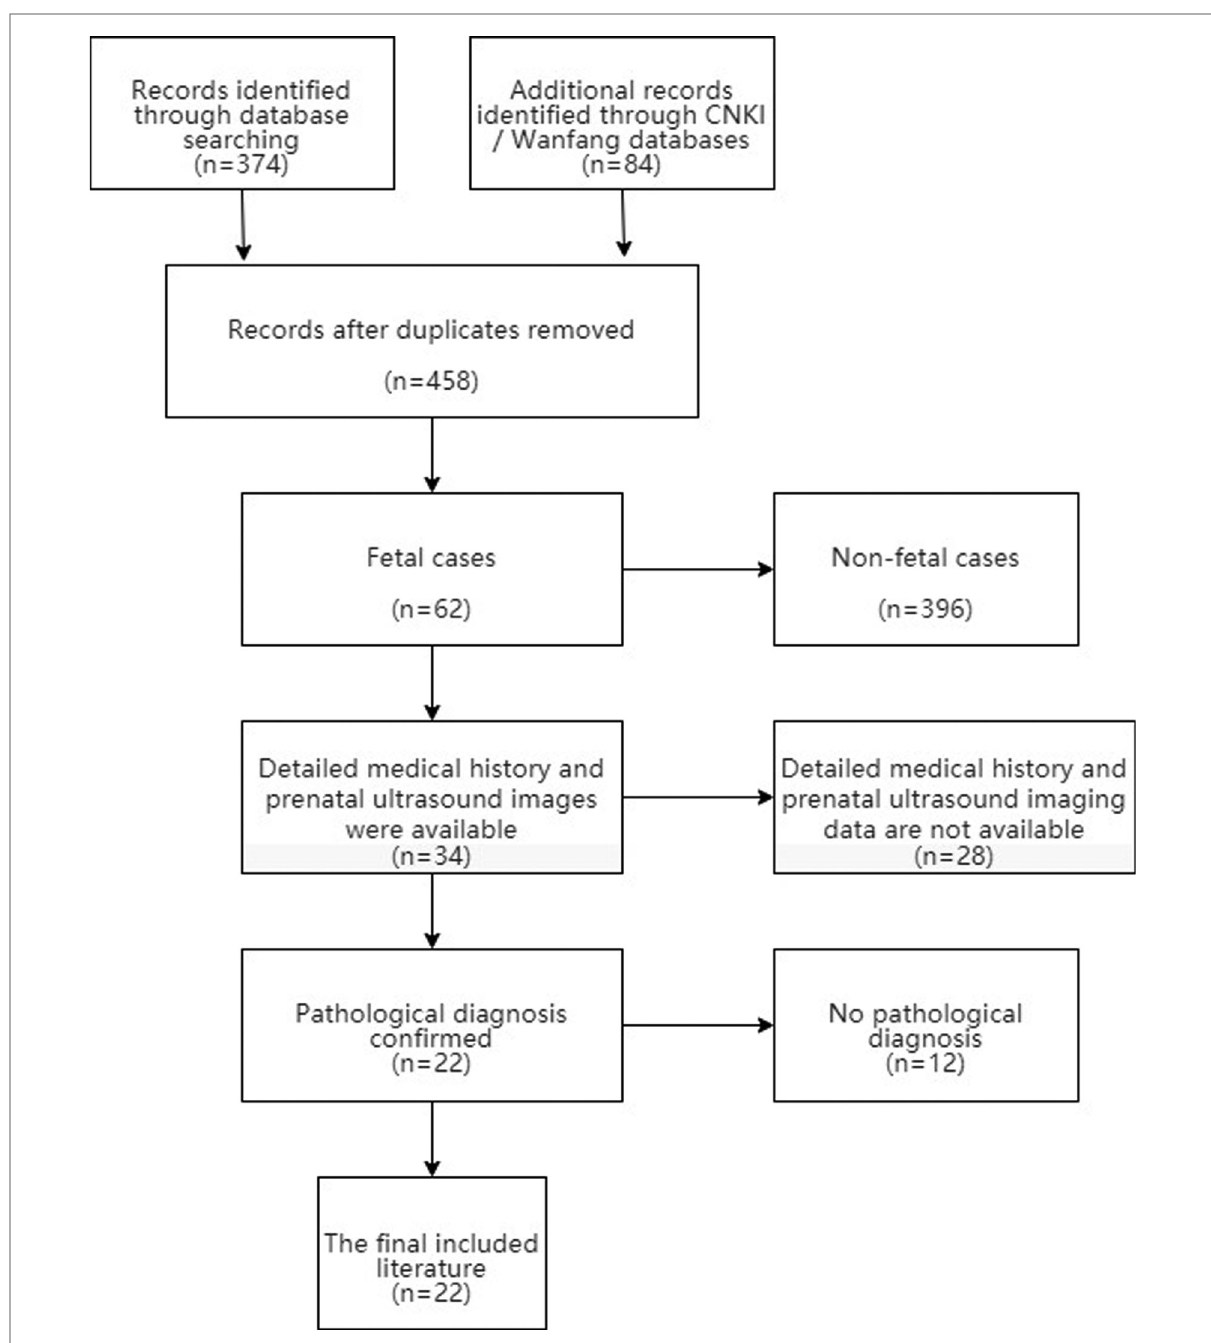
FIGURE 4 Flow chart showing the results of the literature